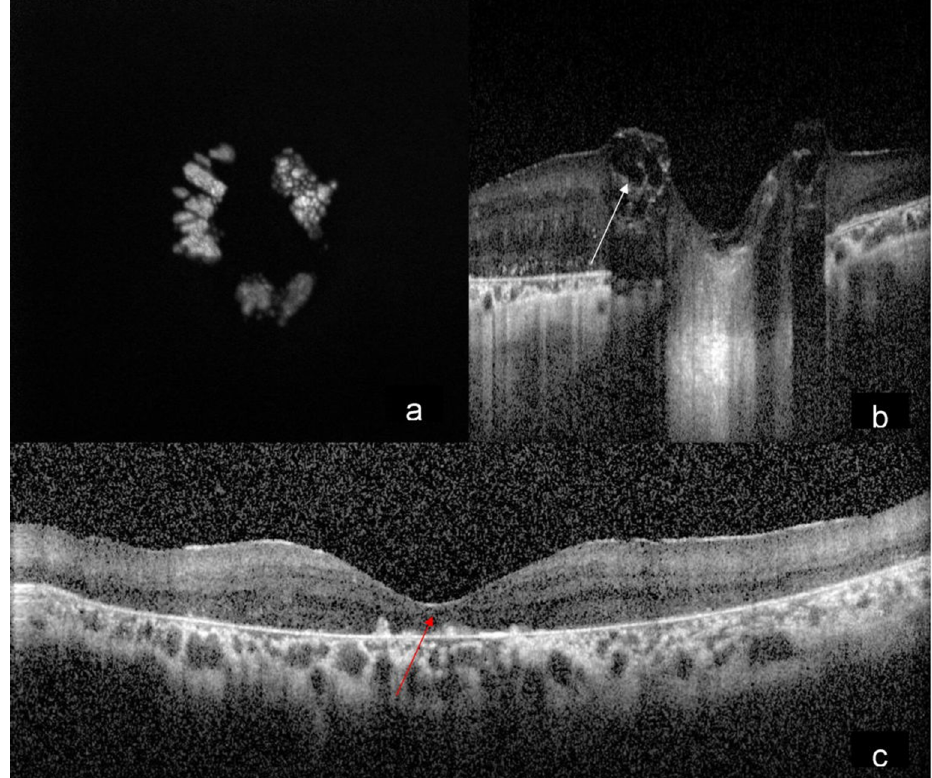
Figure 2: Autofluorescence of the right eye (a) showing typical hyperautofluorescence; SD-OCT showing moth eaten optically empty spaces (b) (white arrow) and hyperreflective dots along with foveal thinning (c) (red